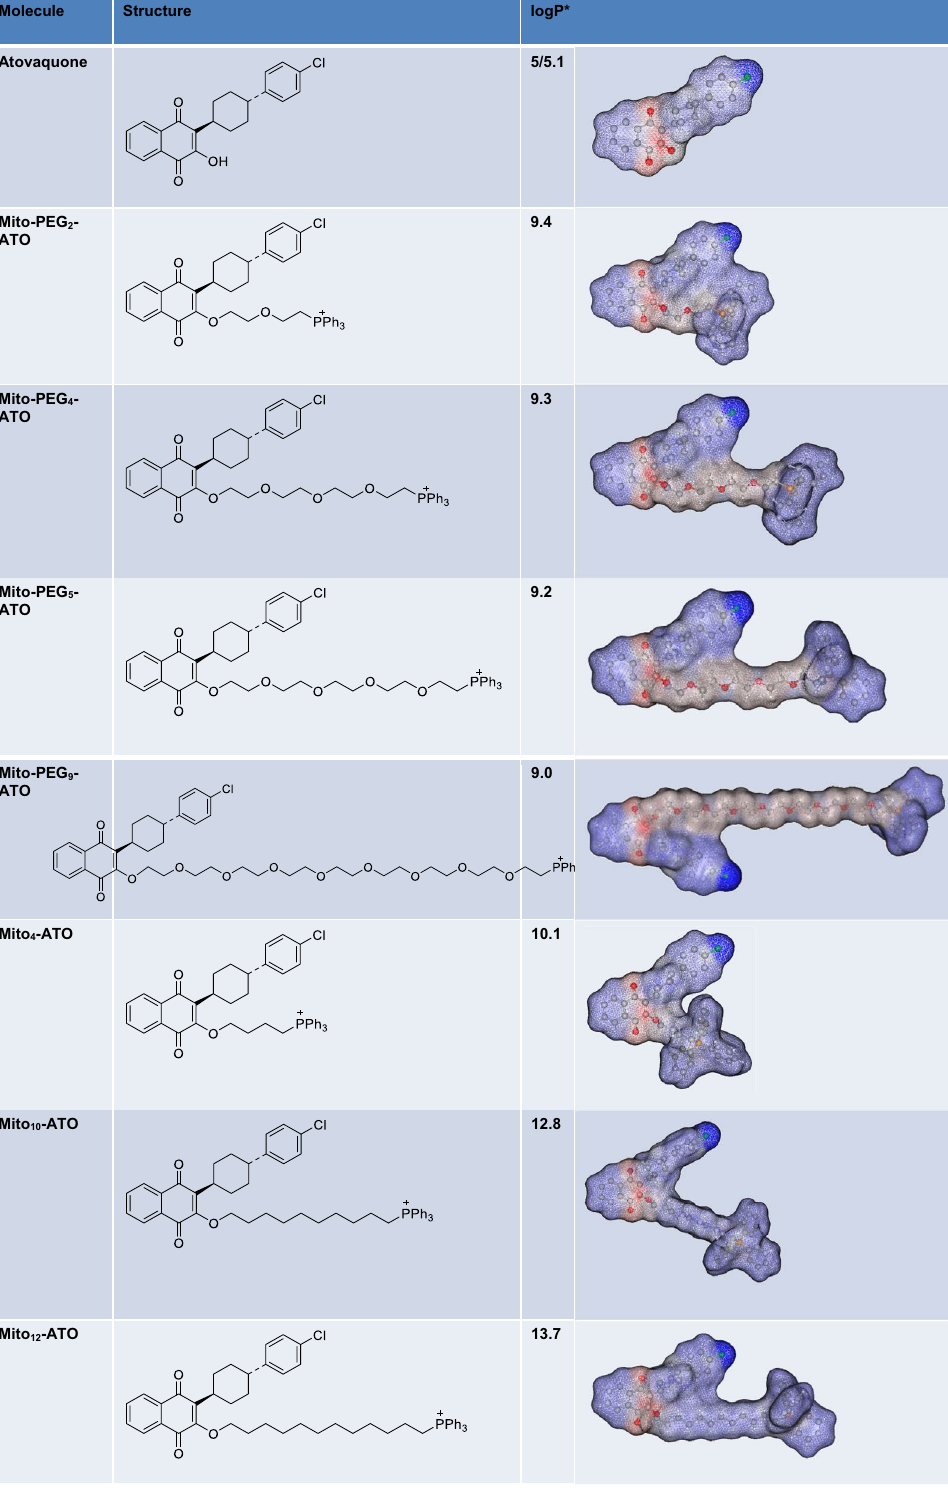
Table 1. Calculated values of the octanol/water partition